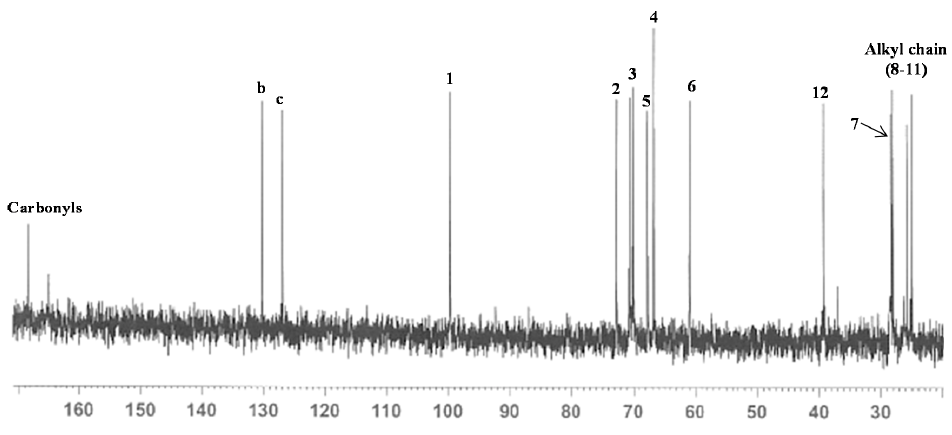
Figure 2. 13 C-NMR spectrum (100 MHz, D 2 O) of glycomonomer 7 .